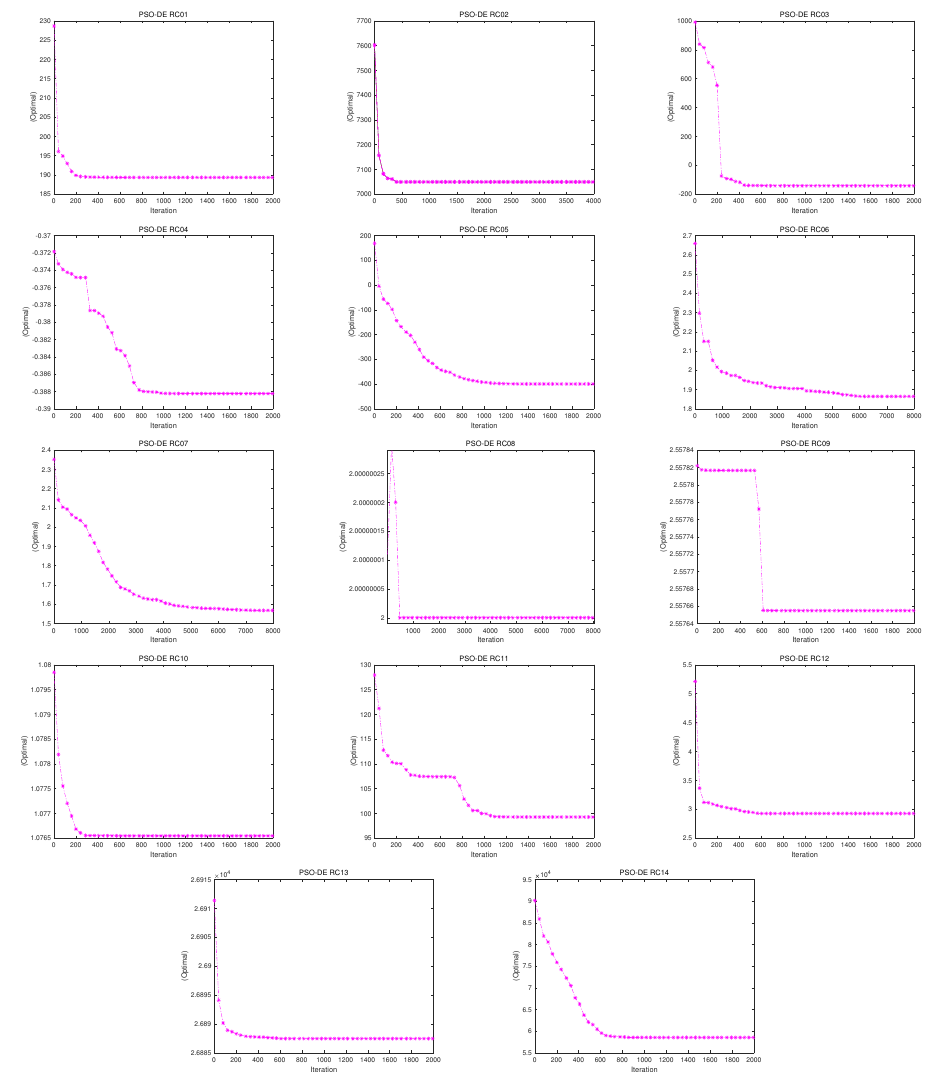
Figure 7. Convergence curve variation of